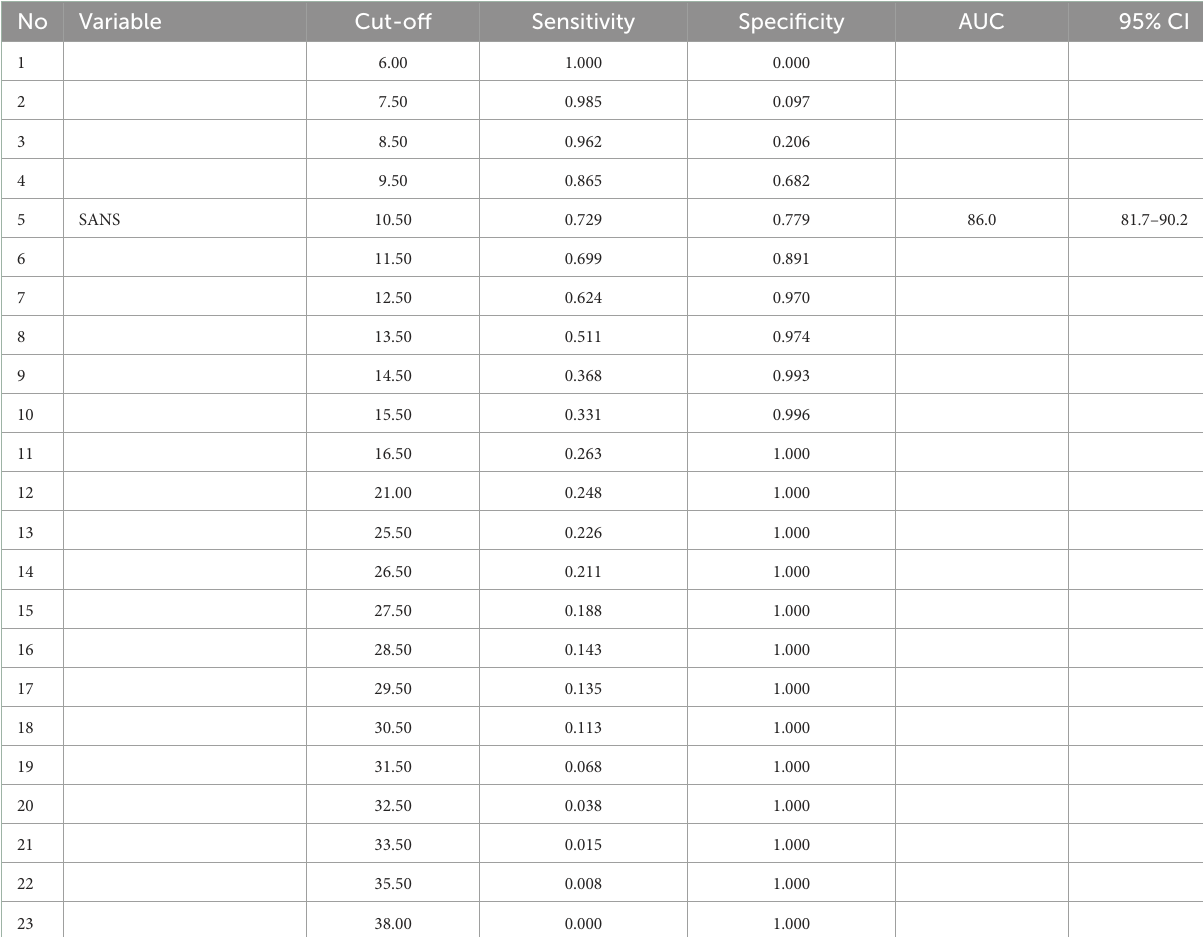
TABLE 7 The sensitivity and specificity values of various alternative intersection points. No Variable Cut-off Sensitivity Specificity AUC 95%